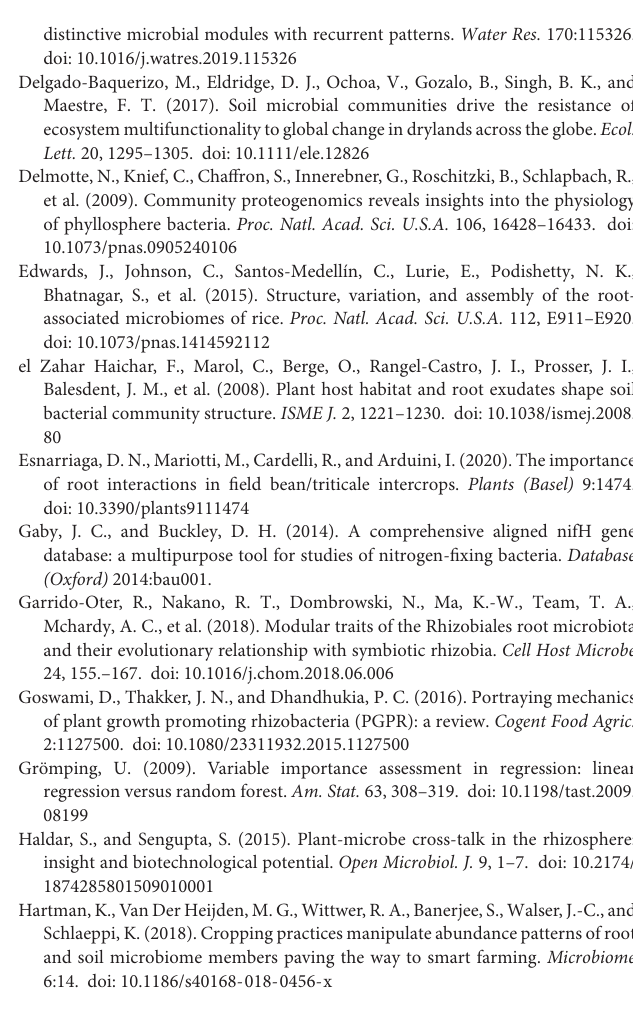
Supplementary Figure 1 | Diagram of planting pattern. Supplementary Figure 2 | The inter module and intra module connectivity values of the two intercropping modes. Dots represent connectors, triangles represent module hubs, squares represent peripheral nodes, and colors represent different phyla, and size represent the relative abundance. Supplementary Figure 3 | Pearson correlation analysis between modules in co-occurrence network analysis and environmental